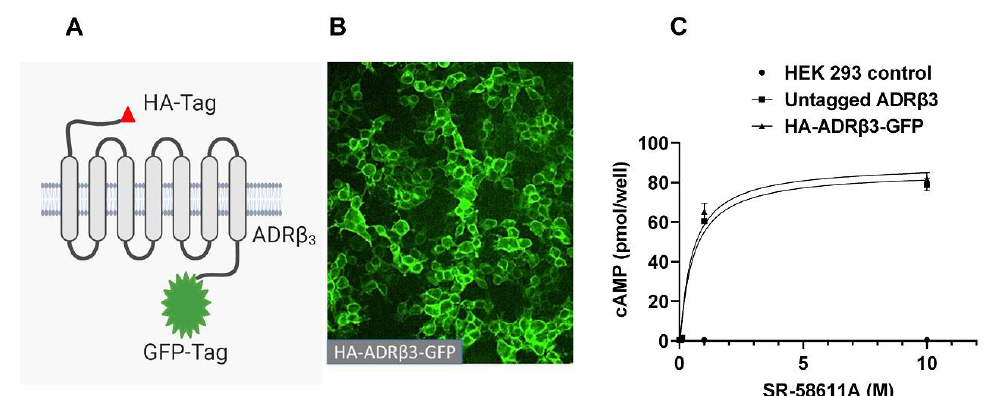
Figure 1. Engineering of HA-ADR β 3-GFP reporter construct and its functional validation. ( A ) HA-ADR β 3-GFP reporter construct was generated by PCR cloning as described in the method section. ( B ) HEK293 cells stably expressing HA-ADR β 3-GFP and visualized under fluorescence microscope (GFP channel). ( C ) β 3 agonist-induced cAMP formation in cells expressing empty vector, untagged ADR β 3, or HA-ADR β 3-GFP.